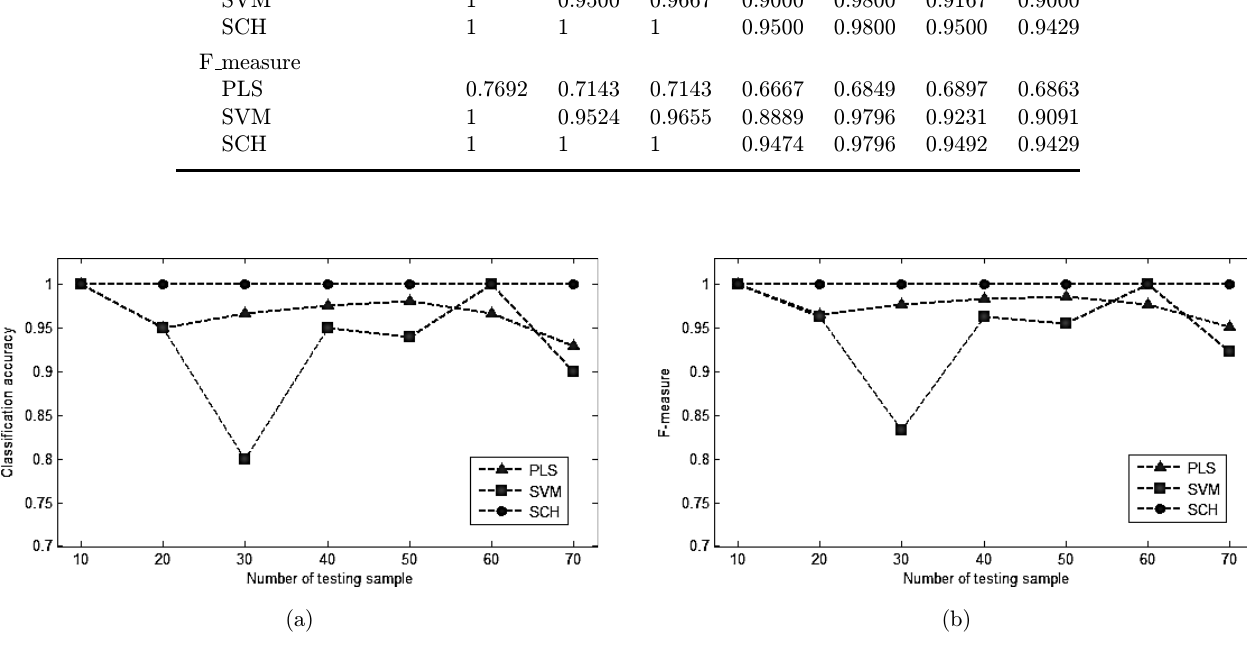
Fig. 6. The classi¯cation accuracy for di®erent drug samples.